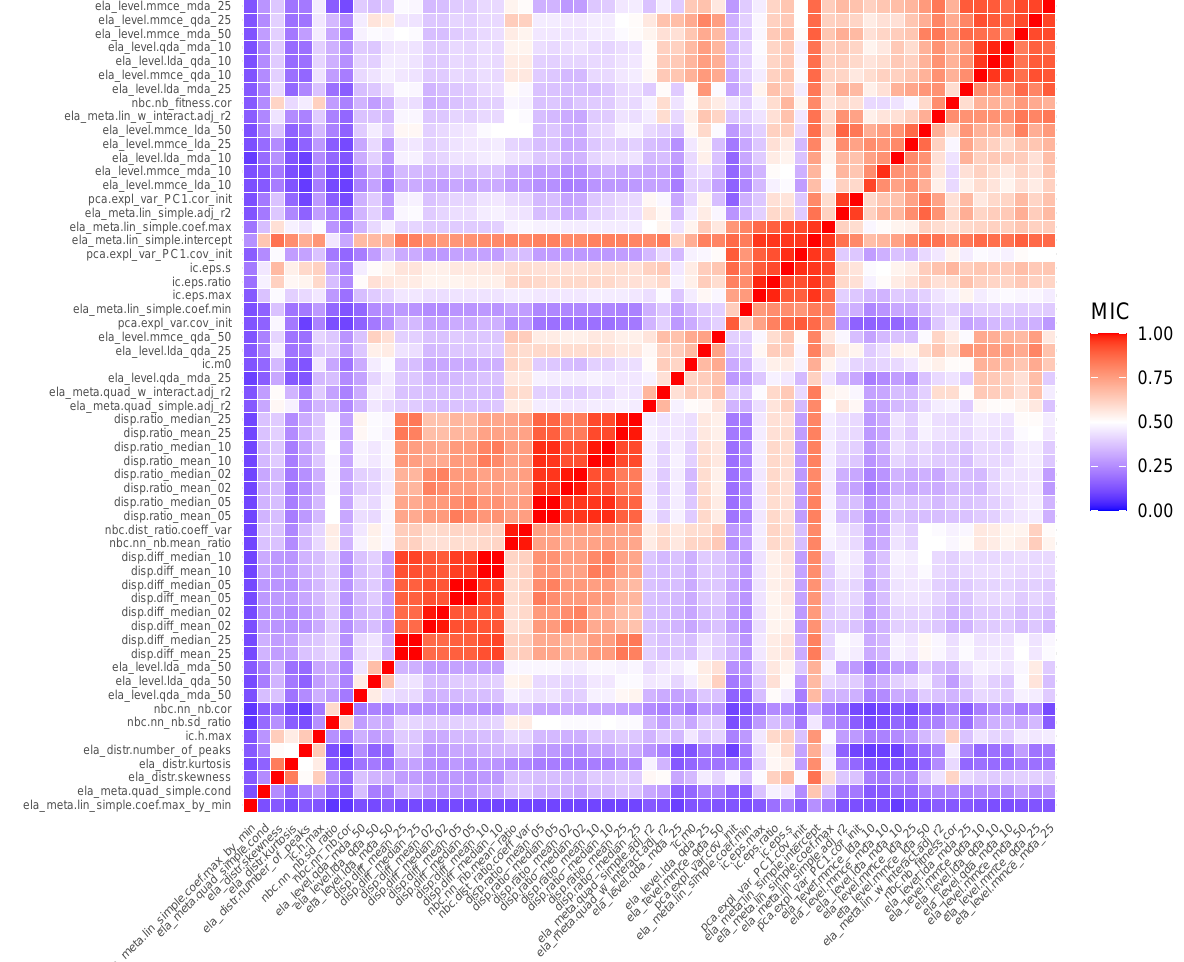
Figure A1. Plot of the maximal information coefficient scores between each of the investigated ELA